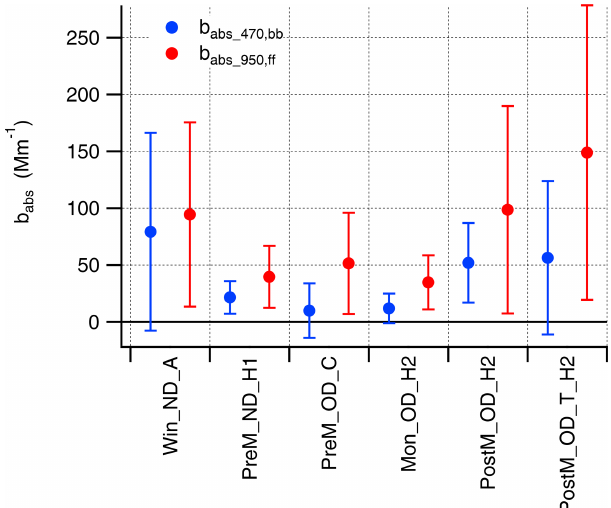
Figure 7. Average absorption coefficients for fossil fuel ( b abs_950ff ) and biomass burning ( b abs_470bb ). The whiskers represent ± 1 stan- dard